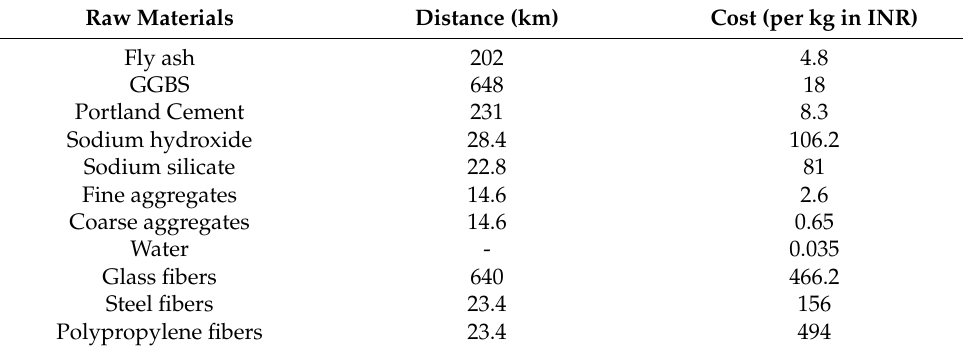
Table 3. Unit cost and freight distance of raw materials.